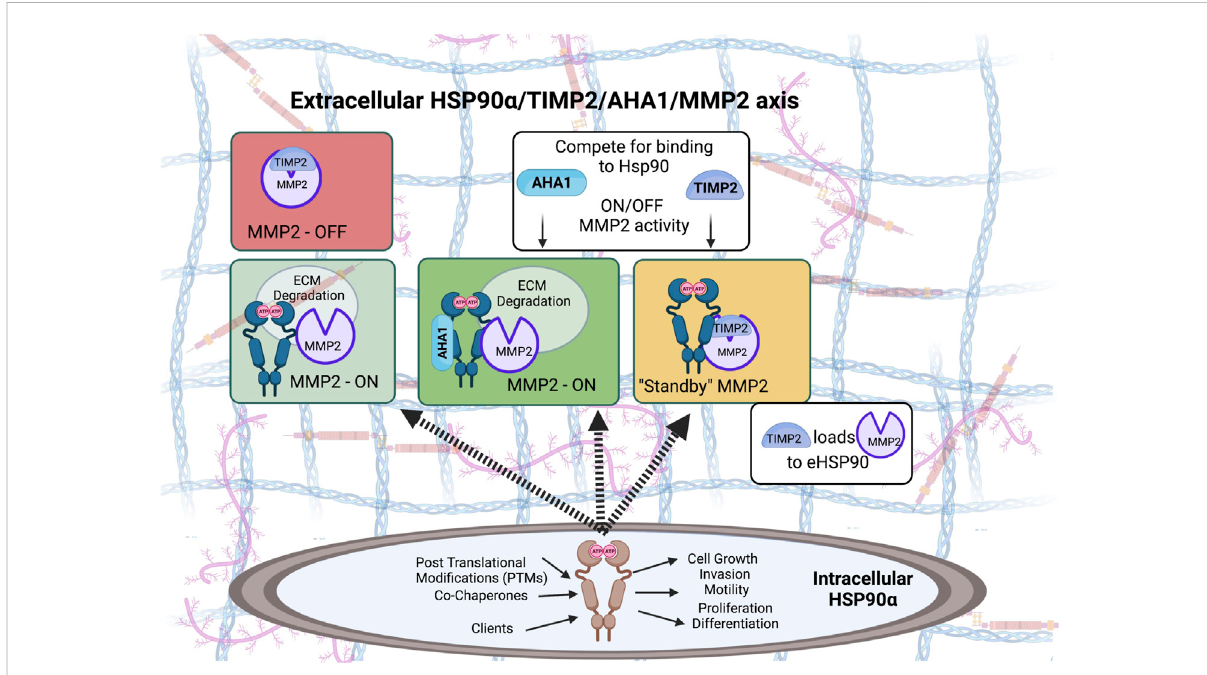
FIGURE 3 Both intracellular and extracellular Hsp90 chaperone machinery has been hijacked to support oncogenesis and tumor progression. Pro- tumorigenic, pro-invasive and pro-angiogenic secretory Matrix metalloproteinase 2 (MMP2) is a protease that degrades components of the extracellularmatrix(ECM).MMP2canfunctionindependentofeHsp90,however,MMP2isstabilizedwhenincomplexwitheHsp90 α isoform.Baker- Williams et al. showed that eHsp90 chaperone function is controlled by a ‘ molecular switch ’ that involves two co-chaperones, TIMP2 — also an endogenous MMP and angiogenesis inhibitor - and AHA1, an Hsp90 activating co-chaperone (Baker-Williams et al., 2019). TIMP2 binding to the eHsp90 α /MMP2 ternary complex sets MMP2 catalytic activity in a Standby-catalytically inactive state, ready to be ‘ re-activated ’ when secreted AHA1 co-chaperone displaces TIMP2 from the